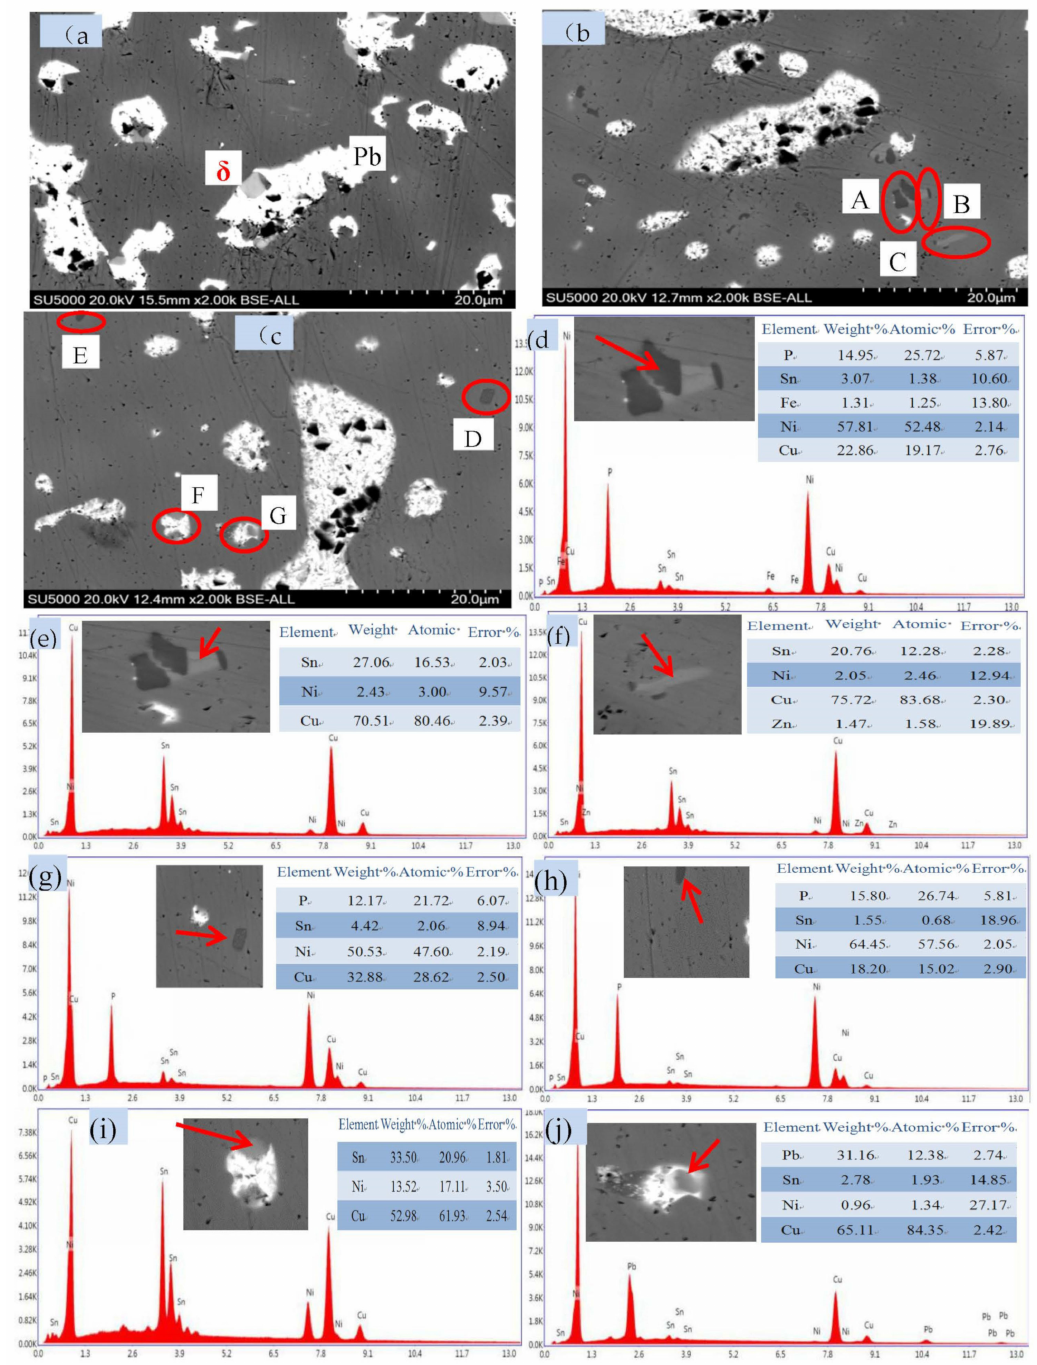
Figure 8. The phase microstructure of the ZCuPb20Sn5-0.1P-yB alloy. ( a ) SEM of alloy with 0 wt.% B; ( b ) SEM of alloy with 0.01 wt.% B; ( c ) SEM of alloy with 0.05 wt.% B; ( d ) EDS of A; ( e ) EDS of B; ( f ) EDS of C; ( g ) EDS of D; ( h ) EDS of E; ( i ) EDS of F; ( j ) EDS of